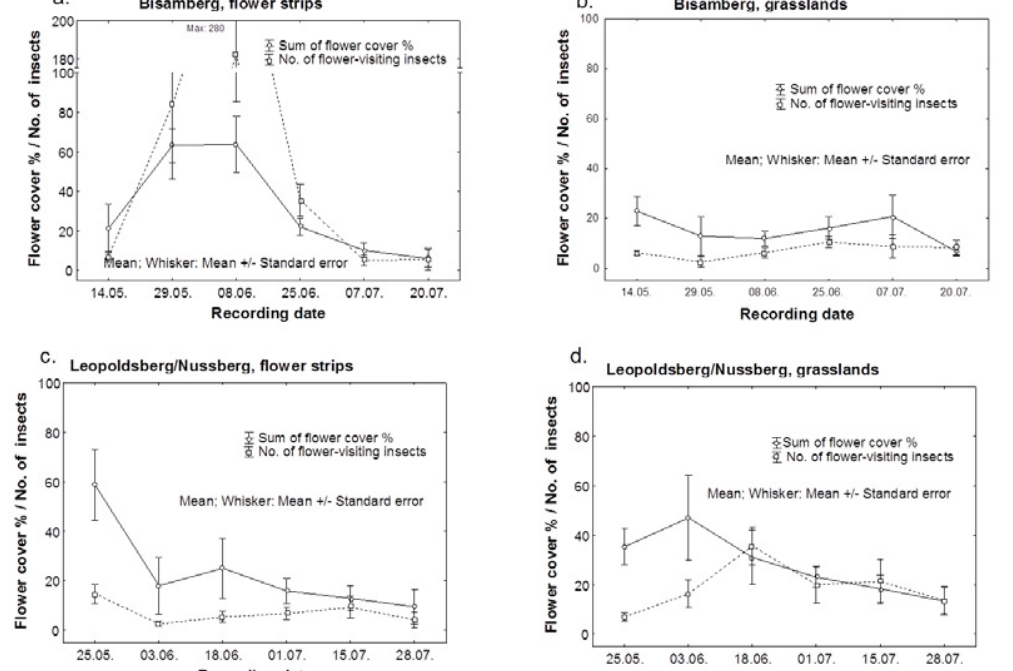
Fig 1 . Temporal dynamic of total flower cover in percent in relation to the total number of flower visiting insects, separated by location (Bisamberg vs. Leopoldsberg/Nussberg) and habitat type (flower strip/ grassland). Year of recording: 2015. Mean and mean +/- standard error is